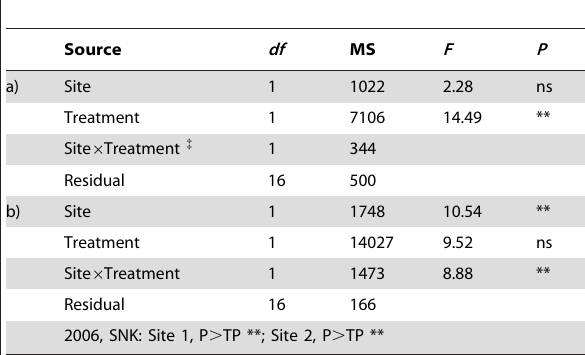
Table 3. Analyses of mean percentage covers of bryozoans on laminae of E. radiata for each individual in the experimental transplantation of urchins to pilings in 2007 (a) and 2006 (b).